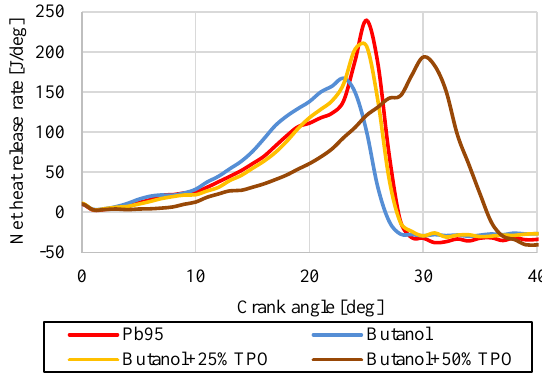
Fig. 6. The net heat release rate for various fuel